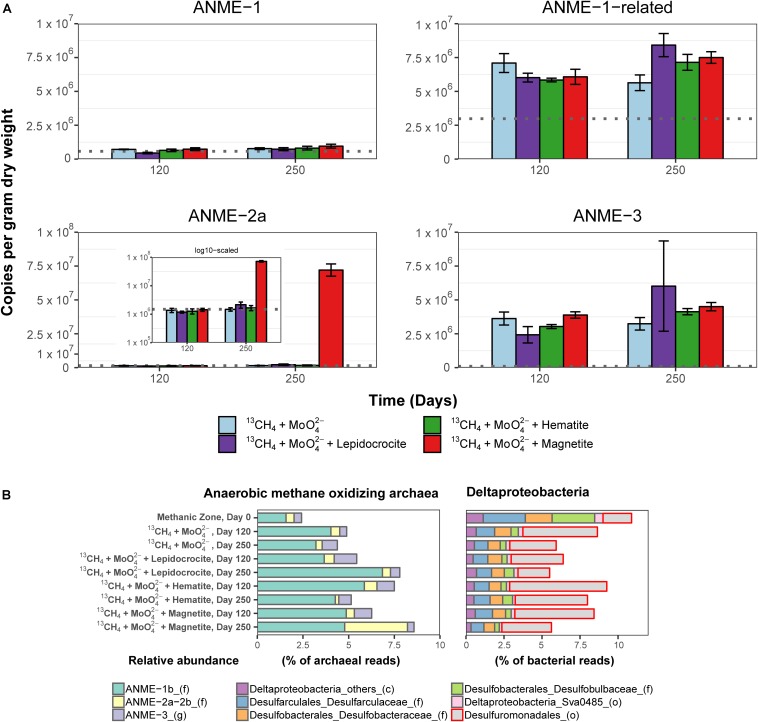
Molecular fingerprints providing insights into microbial activity during 13CH4 oxidation and potential key players involved in Fe-AOM. (A) Abundance of mcrA gene copies assigned to different ANME clades in the methanic zone after 120 and 250 days of incubation in molybdate amended incubations from the methanic zone. Gray line in each plot represents estimates of gene copies of the different ANME phylotypes at respective incubation depths (see Figure 3B) as indication for increasing gene copies during the 250-day incubation experiment. INSET: log scaled, adjusted mcrA gene copies of ANME-2a. mcrA gene copies across all incubations from the sulfate zone and methanic zone are provided in Supplementary Figure S5. Error bars represent 1 s.d. of technical qPCR replicates. (B) Relative abundances of ANME and Deltaproteobacteria based on 16S rRNA gene sequencing in the Fe-AOM incubations from the methanic zone after 120 and 250 days. Relative abundance based on total sum scaling of archaeal and bacterial 16S rRNA genes is provided in Supplementary Figures S3, S4, S7, S9.